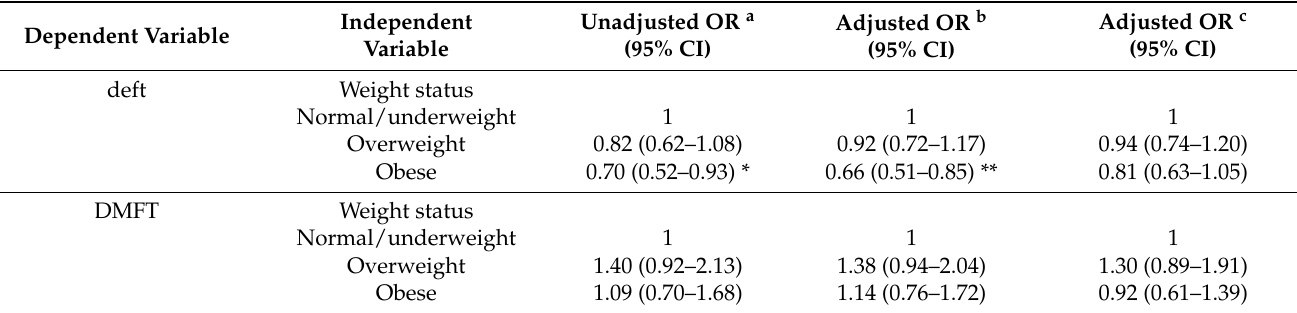
Abbreviations: OR, odds ratio; CI, confidence interval. a Without adjustment for covariates. b Adjustment for age, gender, father’s education level, mother’s education level. c Adjustment for gender, father’s education level, mother’s education level, and number of primary teeth (for deft) or permanent teeth (for DMFT). * p < 0.05, ** p <